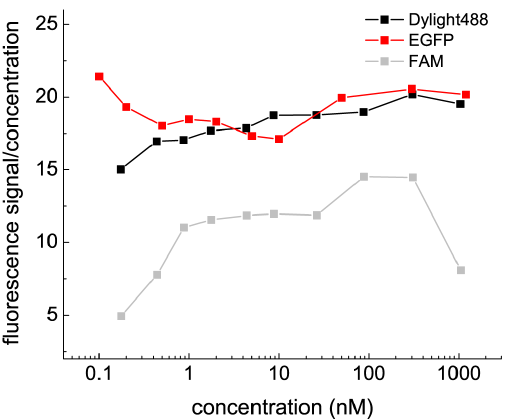
Figure 2. Total sedimentation boundary signals as determined from integration of the c ( s ) distribution, divided by the loaded protein concentration for GluA2 ATD labeled with Dylight488 at labeling ratio 1.43 (black), FAM at labeling ratio 1.32 (grey), and expressed as an EGFP fusion protein (red). Data were acquired at a constant PMT voltage of 36% (Dylight488 and FAM), or 38% (EGFP fusion protein) and signals were divided by the gain factor.